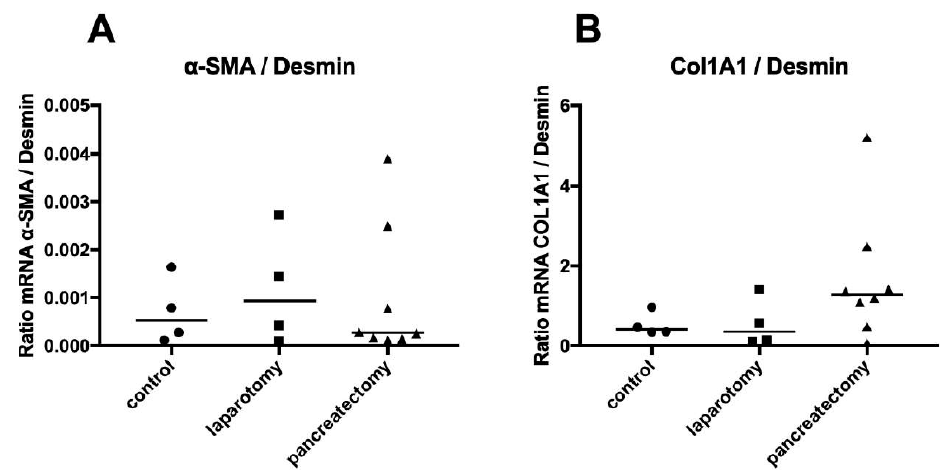
Figure 5. Surgery-mediated liver inflammation is accompanied by enhanced activation of HSCs into HMFs. No surgery as control ( n = 4), explorative laparotomy ( n = 4), or subtotal pancreatectomy ( n = 8) was performed with SCID beige mice which were sacrificed 48 hours after surgery. RNA was isolated from snap-frozen liver tissues to determine mRNA levels of Desmin (marker for quiescent HSC), α -SMA, and Collagen 1A1 (Col1A1) (markers for HMF) by qRT-PCR. Gene expression of target genes was normalized to GAPDH gene expression. Afterwards, ratios of α -SMA to Desmin ( A ), as well as Col1A1 to Desmin ( B ), were calculated for each sample and plotted. Data represent the median and individual values from 4 and 8 animals, respectively.